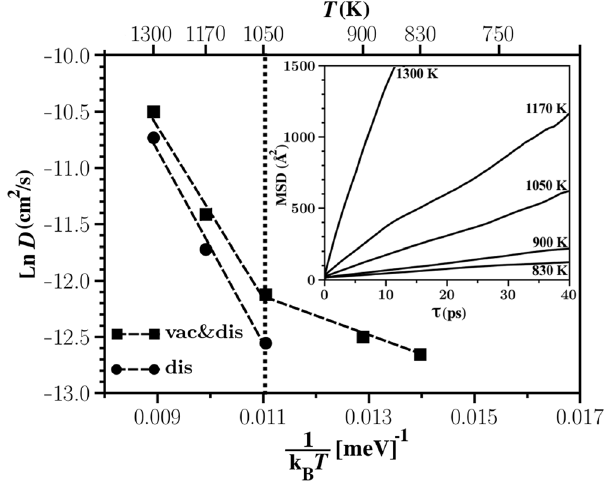
Figure 1. Arrhenius plot of diffusion coefficients in Li 2 S. Diffusion coefficient in the pristine structure is shown by D dis since in this case Li ion migration takes place via temperature–induced disorder (interstitial Li). Li diffusion in Li 2 S with a single vacancy is illustrated by vac&dis as charge carriers are both Li vacancy and disorder (interstitial Li). The inset presents total mean square displacements (MSD) versus lag time calculated for 40 ps AIMD